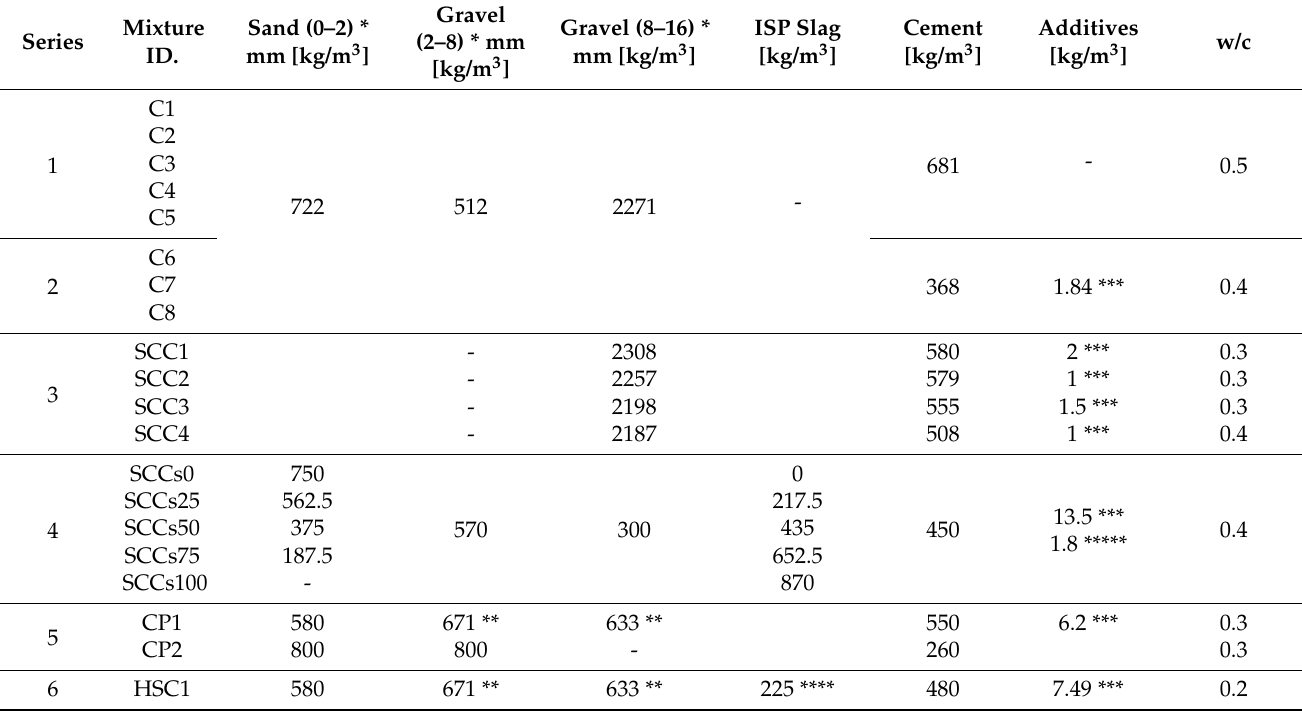
Table 1. Composition of studied concrete mixtures all of